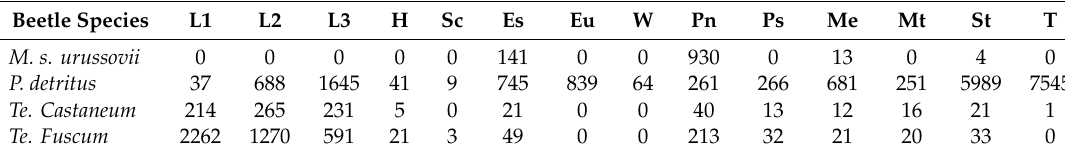
Figure 2. Deutonymphs of Trichouropoda shcherbakae attached to Tetropium fuscum : ( a ) foreleg; ( b ) pronotum. Table 1. Number of deutonymphs attached to various parts of beetles’ body: ( L1 ) forelegs; ( L2 ) midlegs; ( L3 ) hindlegs; ( H ) head; ( Sc ) scutellum; ( Es ) surface of the elytra; ( Eu ) subelytra; ( W ) membranous wings; ( Pn ) pronotum; ( Ps ) prosternum; ( Me ) mesoventrite; ( Mt ) metaventrite; ( St ) abdominal ventrites; ( T ) abdominal